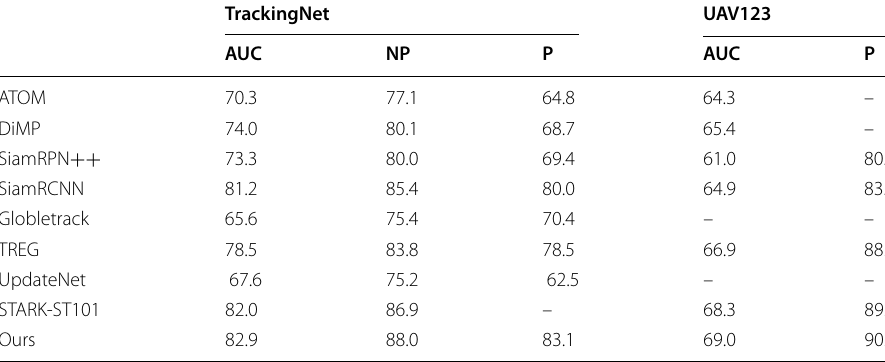
Table 1 AUC on TrackingNet and UAV123 dataset